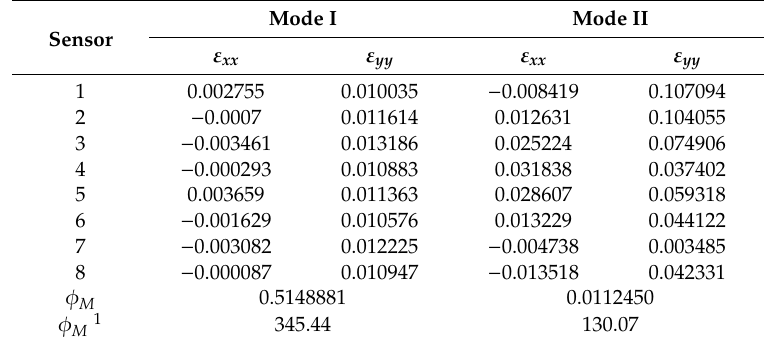
Table 2. Measured strains (unit µ ) of the eight sensors in composite plate with a hole (NI 9237).